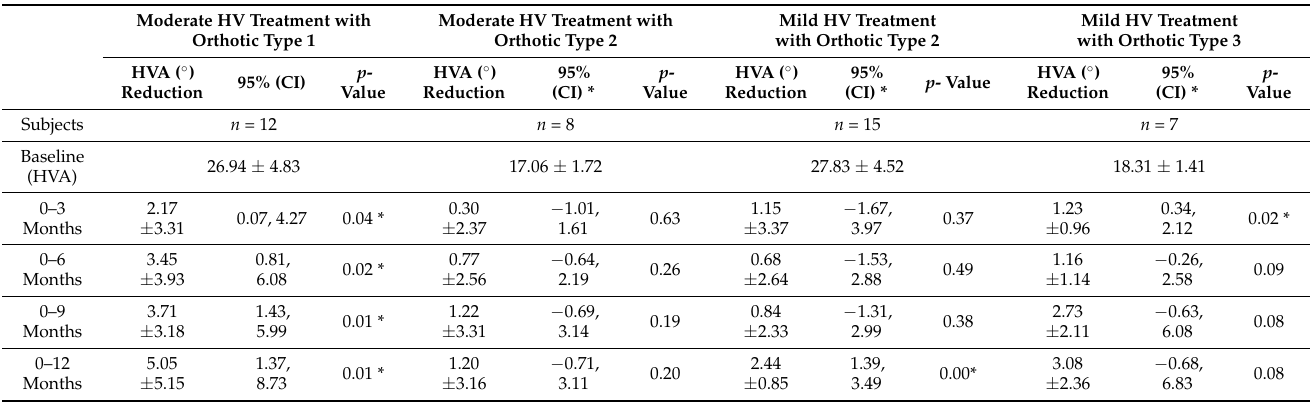
Table 2. Comparison of three orthotics in correction of HVA over a 12-month treatment including 95% confidence interval of the difference and p